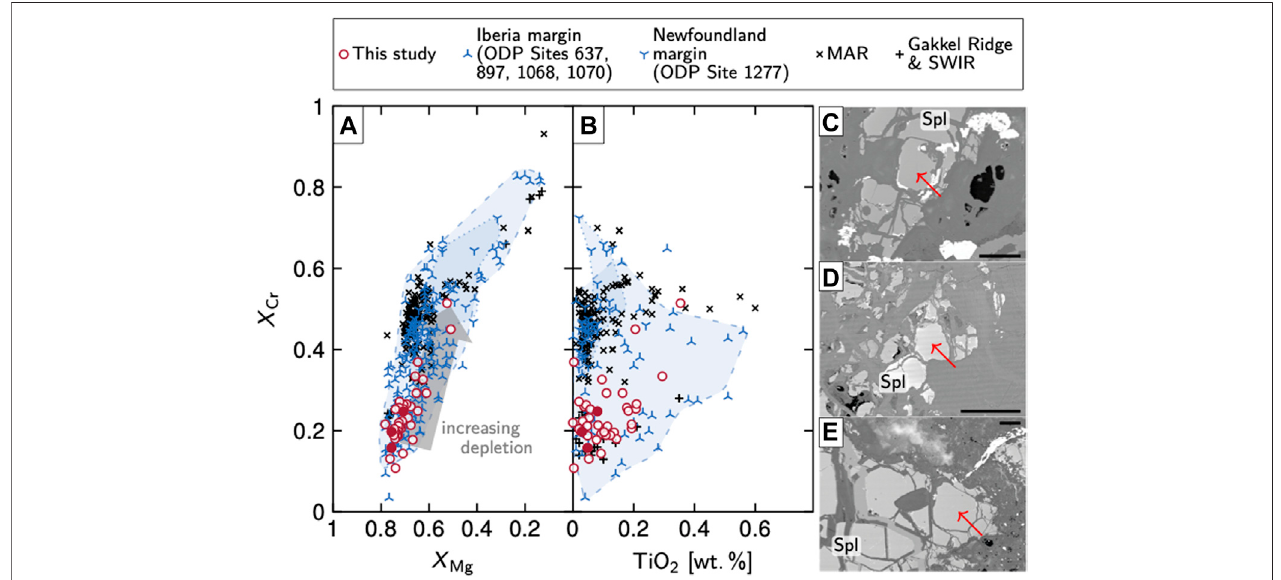
FIGURE 4 | X Mg vs. X Cr (A) and TiO 2 vs. X Cr (B) characteristics of spinel in Hole 637A rocks. Spinels are Mg- and Al-rich and generally indicate little melt depletion. The three solid red circles correspond to the spinel grains in BSE images (C) to (E) (samples 27R-1, 107 – 110 cm, 27R-2, 65 – 68 cm, and 28R-1, respectively; arrows show analysis locations; scale bars are 100 µm). Spinel compositions from other sites at the Iberia – Newfoundland conjugate margin (areas with dashed and dotted outlines, respectively) and from the slow-spreading MAR and the ultraslow-spreading Gakkel and Southwest Indian Ridges are shown for comparison. Data are from Evans and Girardeau (1988), Cornen et al. (1996; analyses of spinel cores only), Seifert and Brunotte (1996), Abe (2001), Hebert et al. (2001; digitized with WebPlotDigitizer, https://automeris.io/WebPlotDigitizer/), Hellebrand et al. (2002), Chazot et al. (2005); Müntener and Manatschal (2006), Seyler et al. (2007), Moll et al. (2007),Tamuraetal.(2008),Vilsetal.(2008),Silantyevetal.(2011),Kodolányietal.(2012)andDessimoulieetal.(2020).Allvaluesarecationsperformulaunit,calculated on the basis of four O with all Fe treated as ferrous. Abbreviations: MAR, Mid-Atlantic Ridge; Spl, spinel; SWIR, Southwest Indian